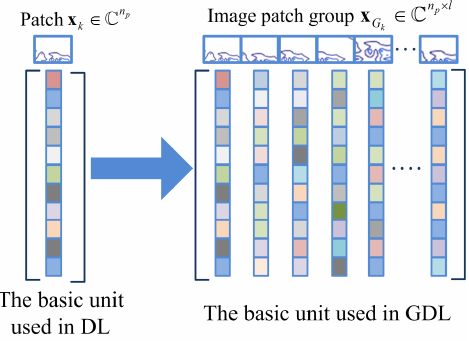
Figure 3. The comparison between image patch x k and image patch group x G